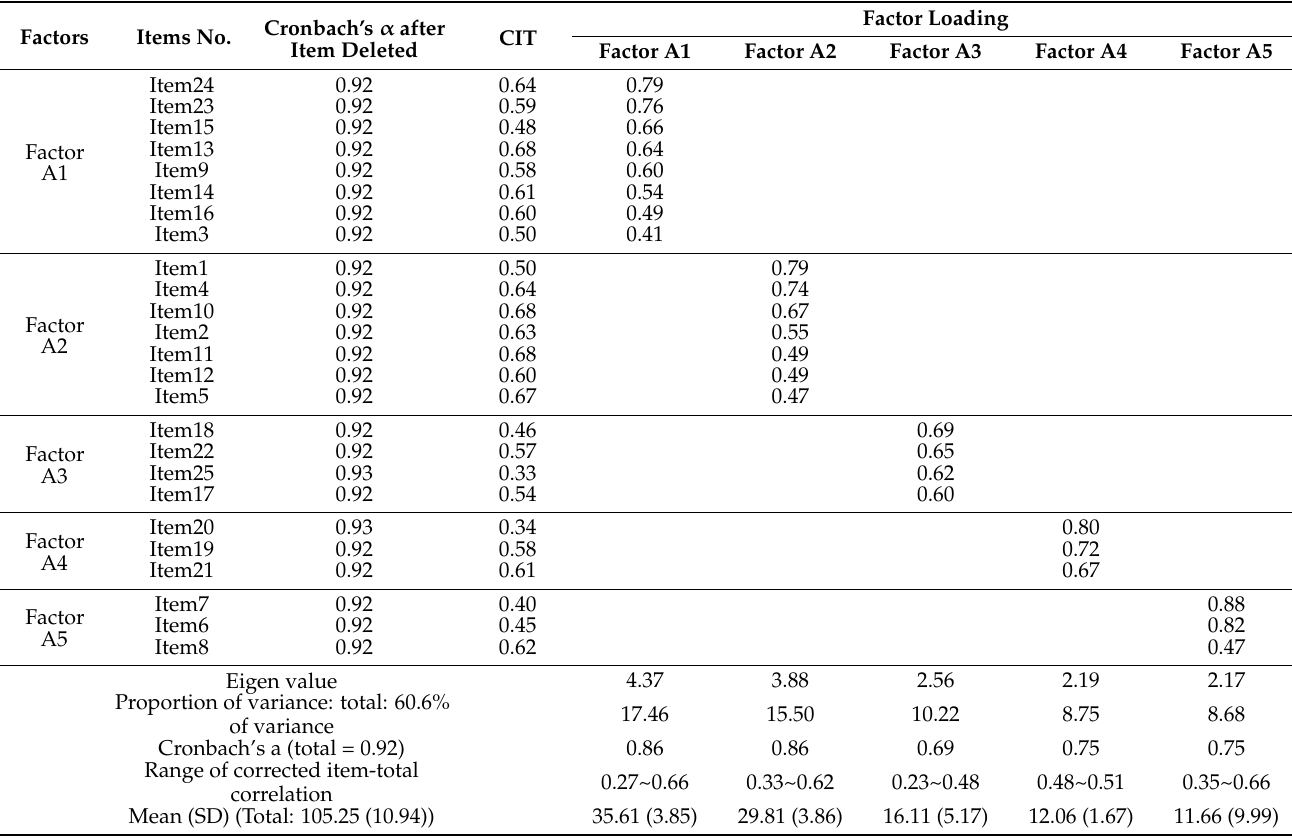
Table 3. Corrected item-total correlation and factor loadings in EFA using data set A ( n =